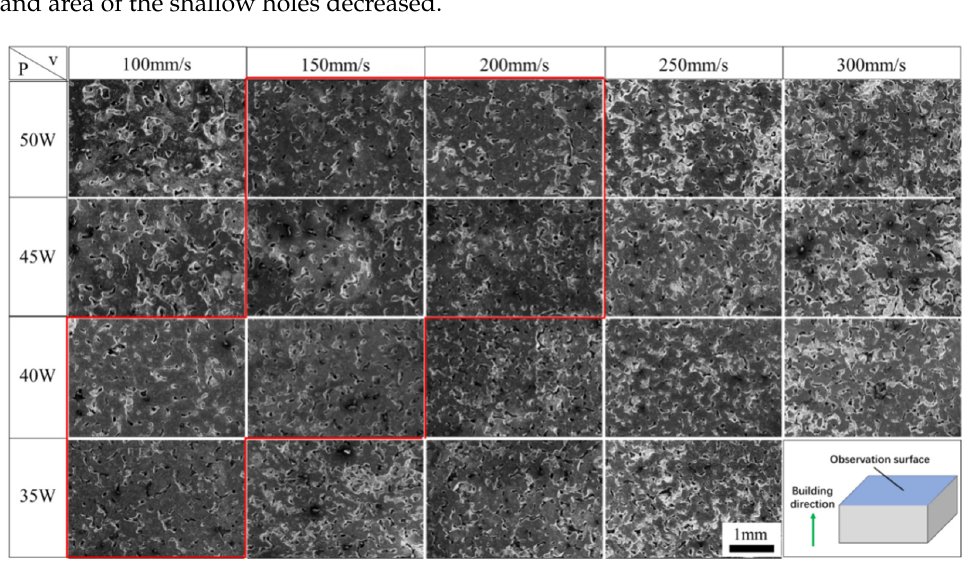
Figure 10. Low-magnification SEM images of ISLF samples.